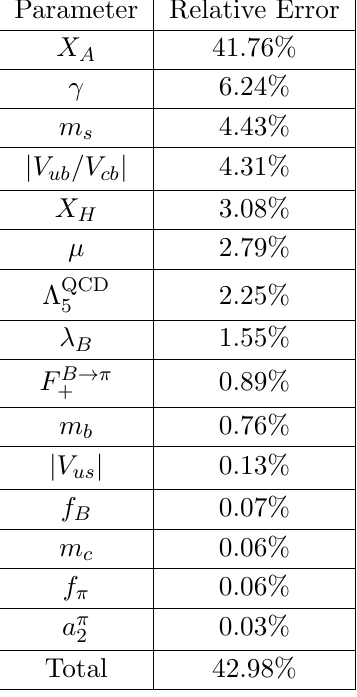
Table 3 . Error budget for the observable S (cid:25)(cid:25) . Most of the inputs coincide with those for R (cid:25)(cid:25) described in table 2. Additionally the e(cid:11)ects of annihilation topologies are accounted by X A . level enters mainly through (cid:11) (cid:25)(cid:25) , which according to eq. (2.20) has a leading dependency 2